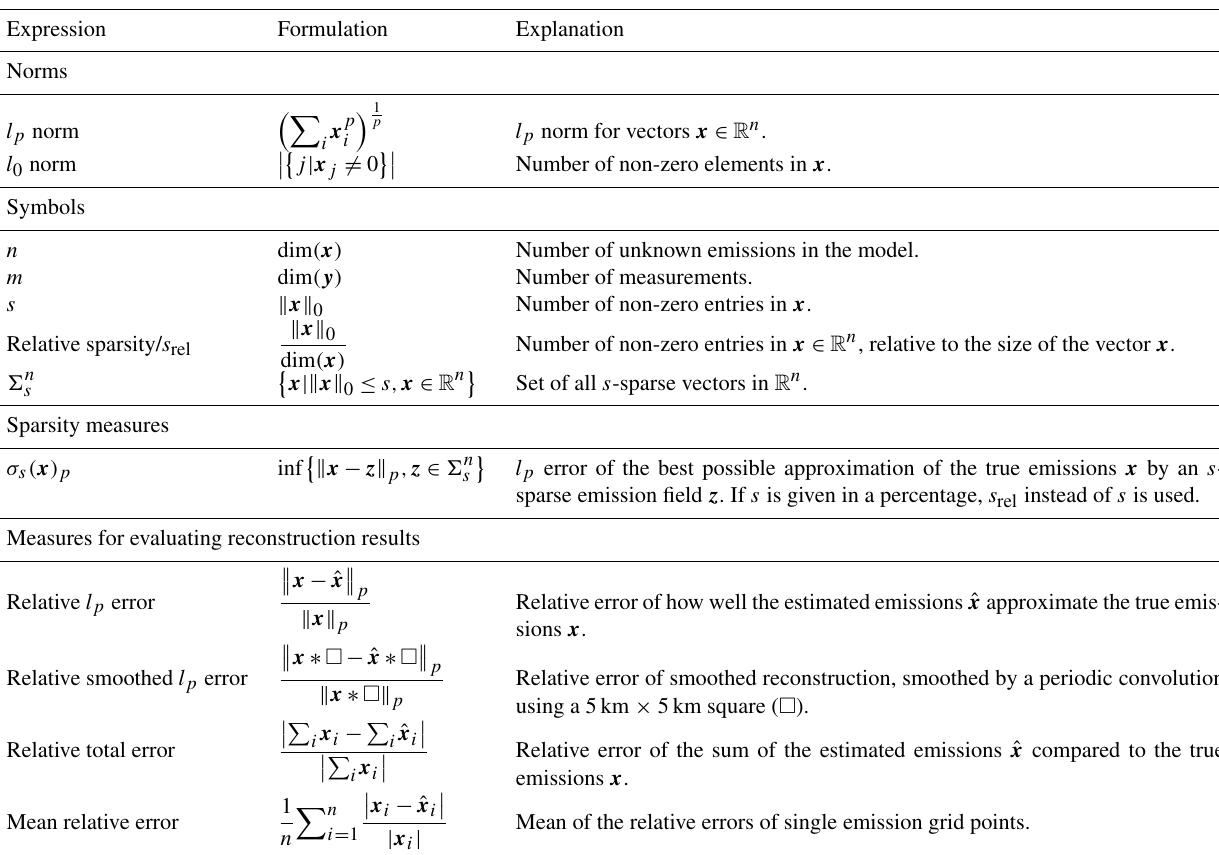
Table 1. Table of symbols and measures used in the paper. Expression Formulation Explanation